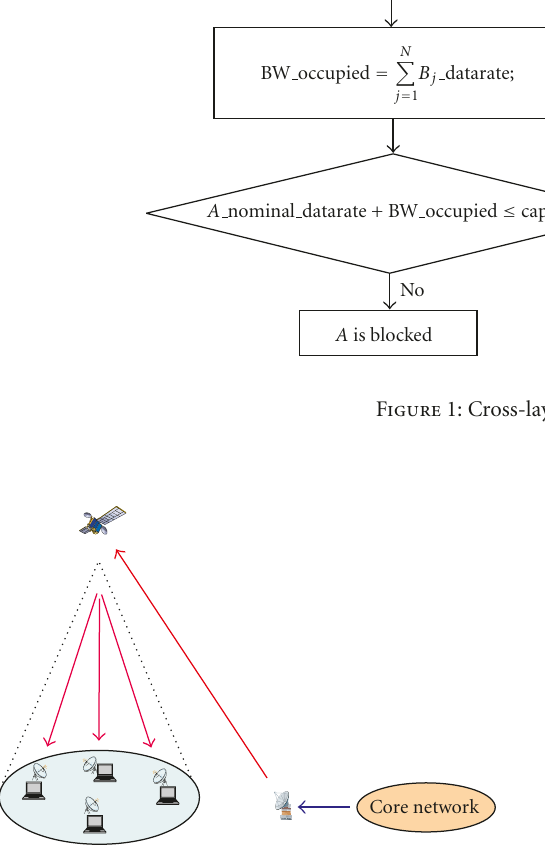
Figure 2: Stand-alone GEO